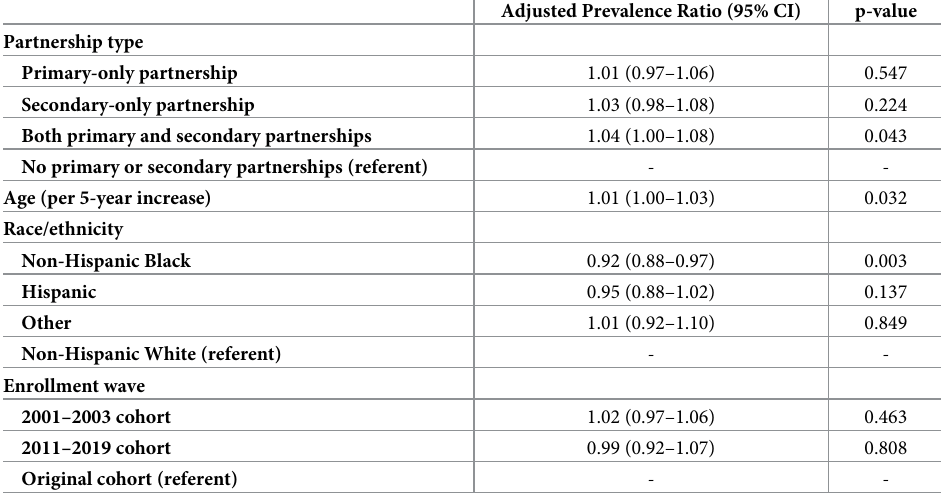
Table 3. Adjusted association of partnership type and viral load